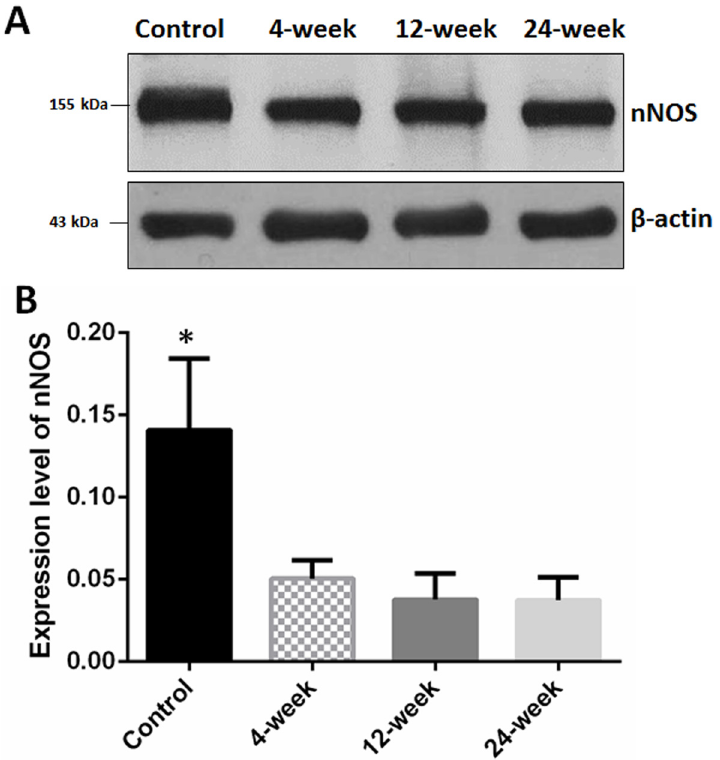
Fig 2. Western blot for neuronal nitric oxide synthase (nNOS). (A) Western blot normalized to β -actin; (B) mean nNOS positivity. Mean nNOS was significantly higher in the control group compared with all others ( * versus all other groups p < 0.05).